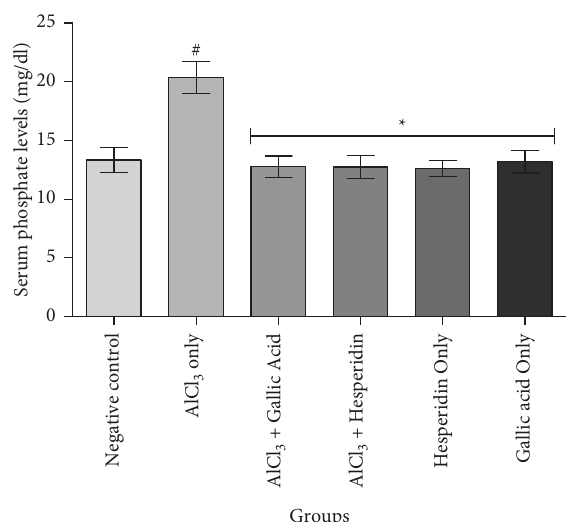
Figure 5: Effect of gallic acid and hesperidin on the serum phosphate level in AlCl 3 -induced nephrotoxicity in Wistar rats. Values are expressed as the mean ± standard deviation of six de- terminations. # p < 0 . 05 vs negative control, ∗ p < 0 . 05 vs. AlCl 3 only.